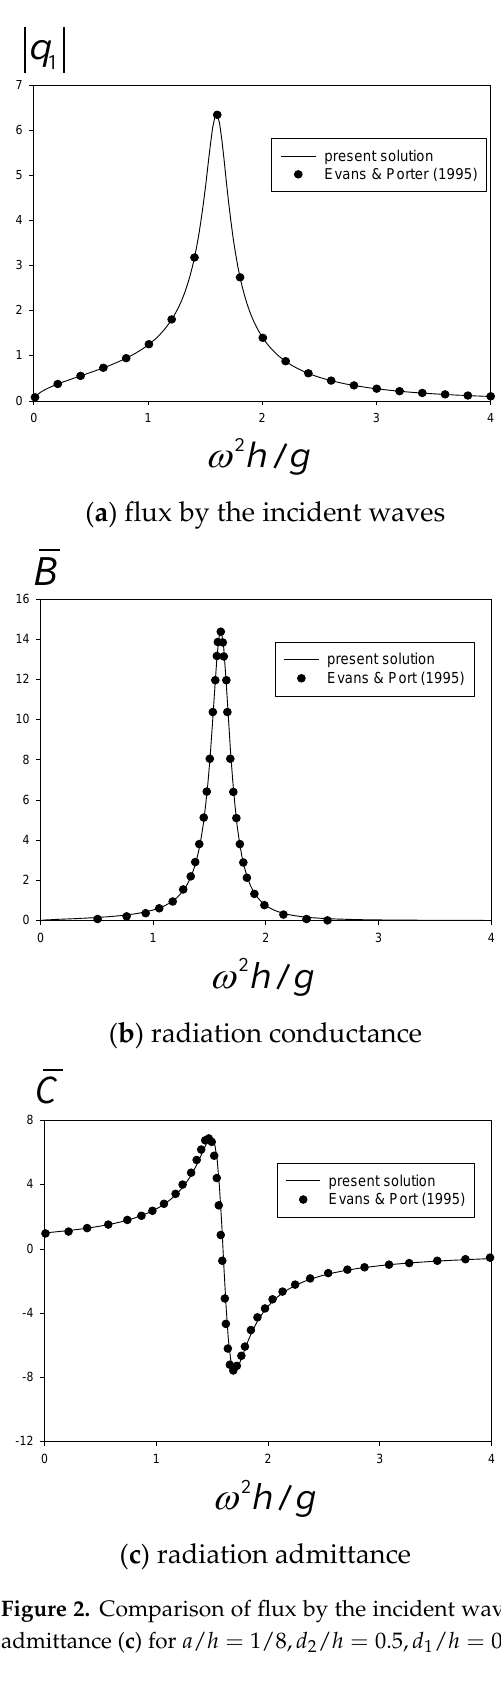
Figure 2. Comparison of flux by the incident waves ( a ), radiation conductance ( b ), and radiation admittance ( c ) for a / h = 1/8, d 2 / h = 0.5, d 1 / h =